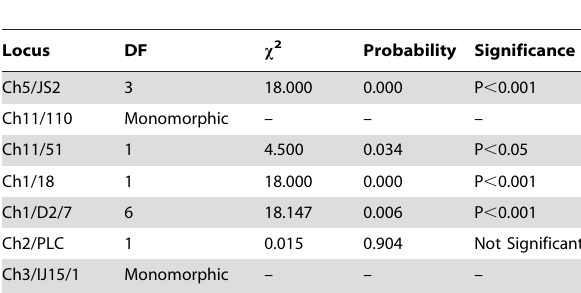
Table 6. Hardy-Weinberg analysis of group 1 T. b. gambiense isolates at the Coˆte d’Ivoire focus (N= 20).